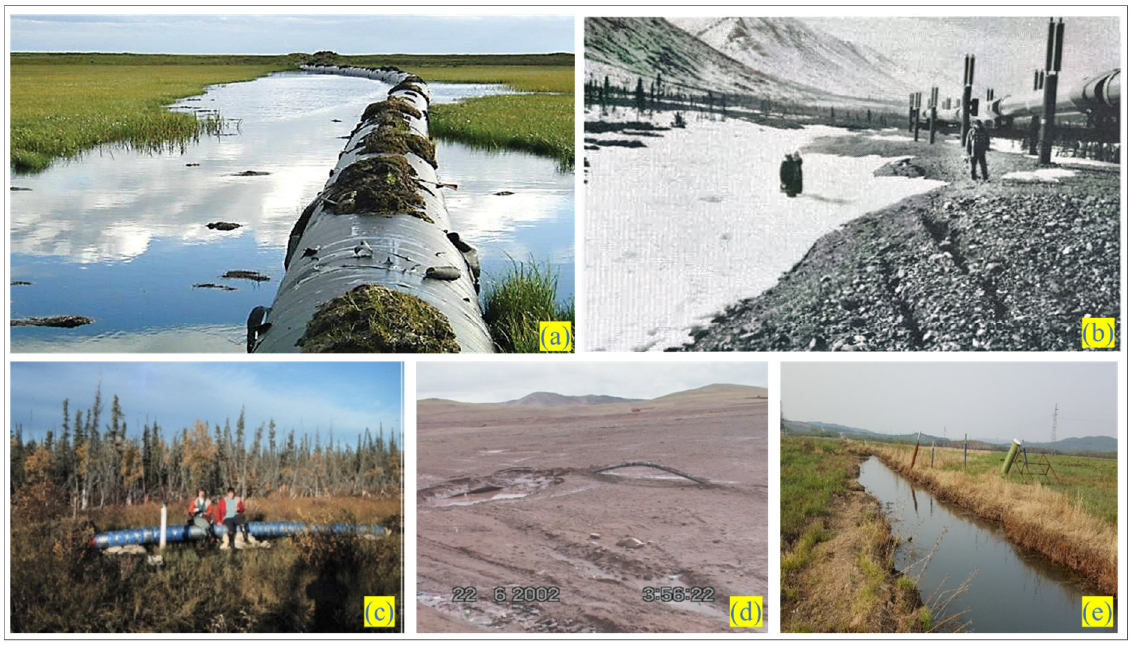
Figure 1. Common oil and gas pipeline damages in permafrost regions. ( a ). The Medveje gas pipeline that once was buried and now is floating in a marsh, resulting partly from the thawing of the permafrost [19]; ( b ). Differential settlement of the workpad in an elevated pipeline segment of the Alaska pipeline [11]; ( c ). Frost heaving of the buried Norman Wells Pipeline in September 1997 [20]; ( d ). Frost heaving and deformation at Wuli of the Product Pipeline from Golmud to Lhasa in June 2002 [20]; ( e ). Surface subsidence occurs in some areas where the CRCOP crosses permafrost regions, resulting in the formation of ponds.